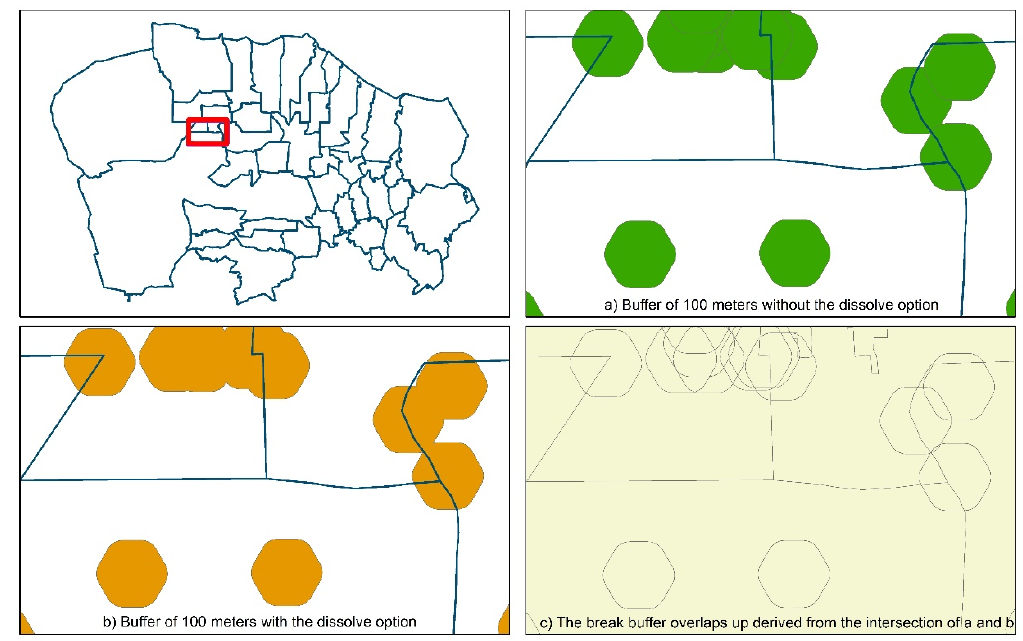
Figure 3. The steps for creating the break buffer overlaps up (detailed view): ( a ) buffer of 100 meters without the dissolve option; ( b ) buffer of 100 meters with the dissolve option; ( c ) the break buffer overlaps up derived from the intersection of ( a ) and ( b ).